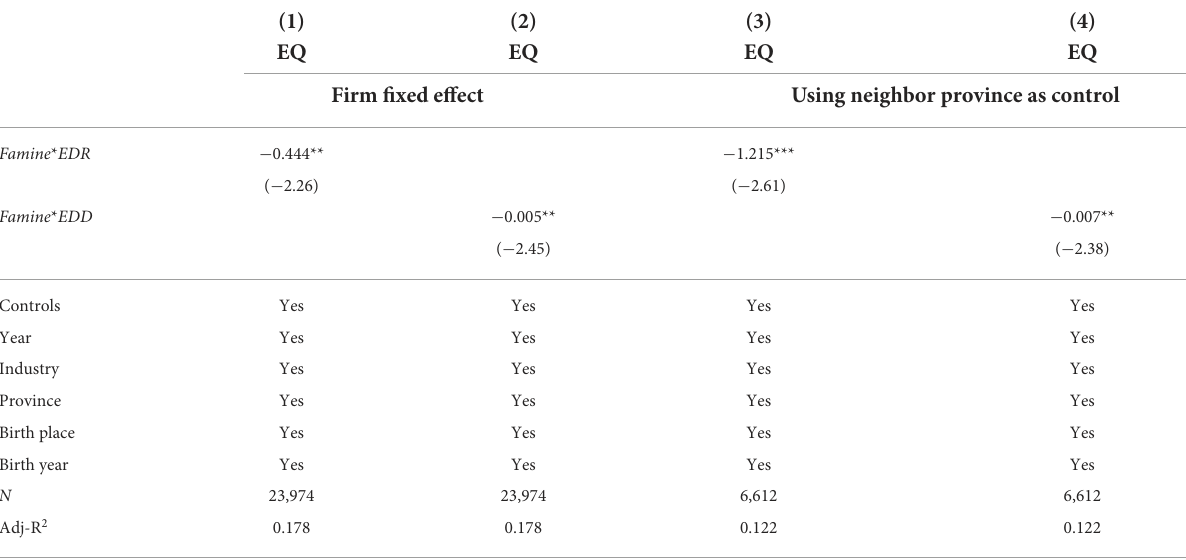
TABLE 7 CEO famine experience and corporate earnings quality—the effects of firm fixed effects and regional